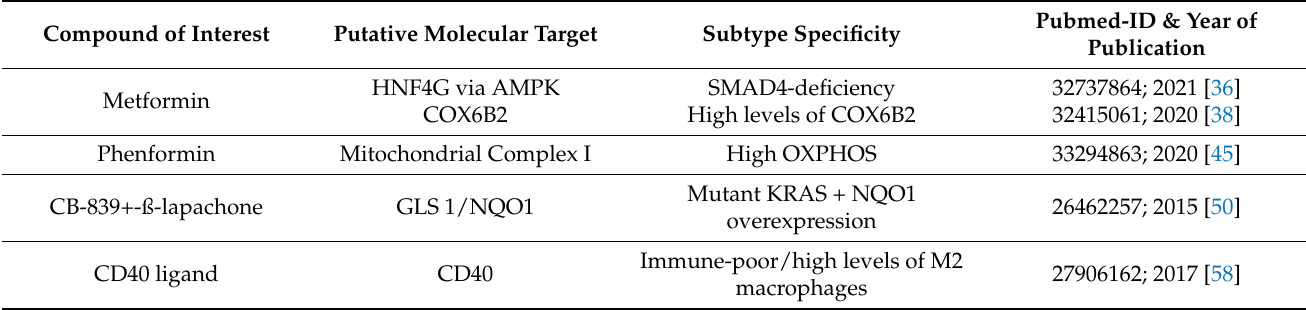
Table 1. Novel therapeutic targets discovered in preclinical trials considering tumor heterogeneity for patient stratification. Compound of